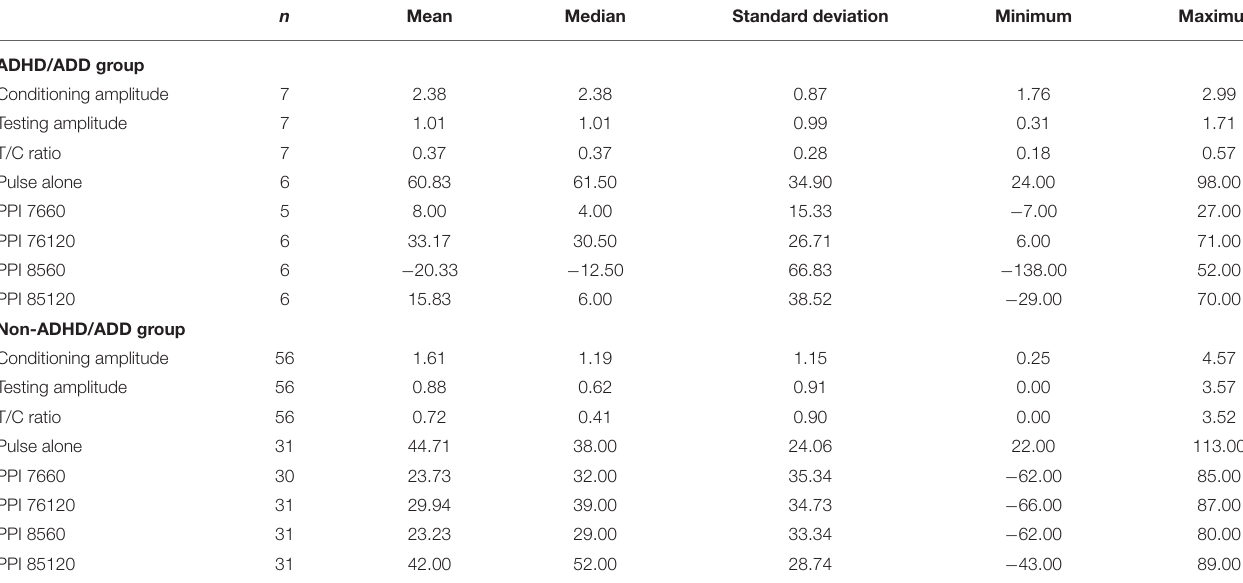
TABLE 5 | Descriptive statistics of the ADHD/ADD group and non-ADHD/ADD group concerning psychophysiological measures. n Mean Median Standard deviation Minimum